Question: In one sentence, what is this figure communicating?
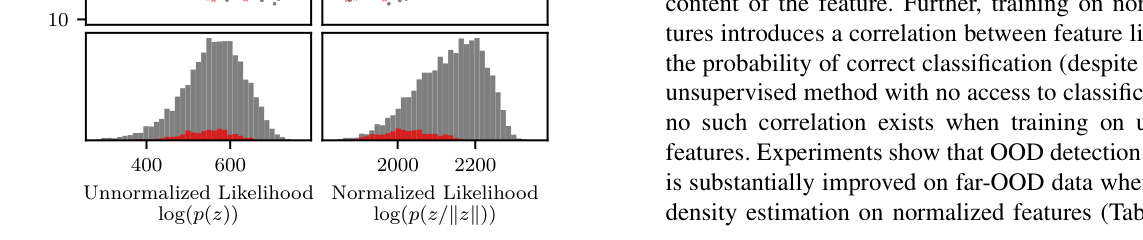
Answer: Visualization of feature vector norms vs. log- likelihood for a flow model trained with normalized (left) and unnormalized (right) feature vectors. For a flow model trained on unnormalized features, there is no correlation between feature norm, classification accuracy, and flow likelihood. For a flow model trained on normalized features, a correlation is observed between feature norm, classification accuracy, and flow likelihood.